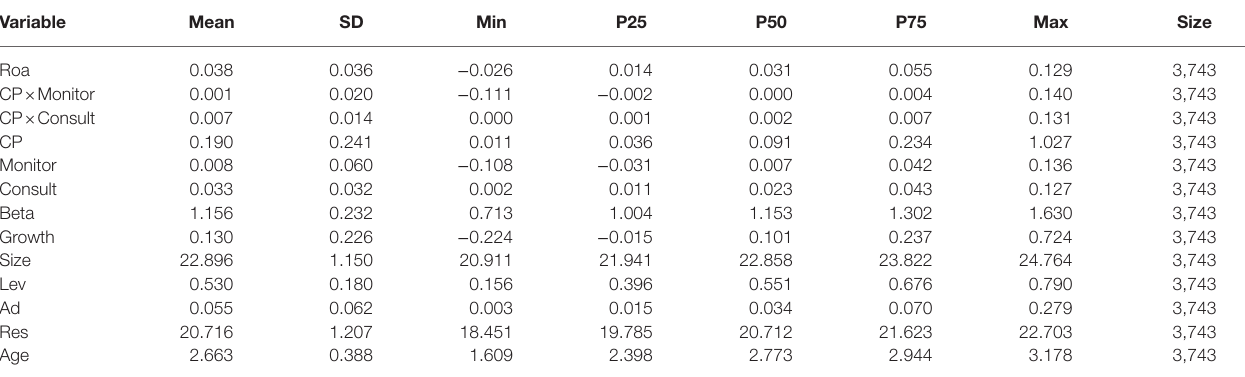
TABLE 1 | Descriptive statistics of the main variables (SOEs).